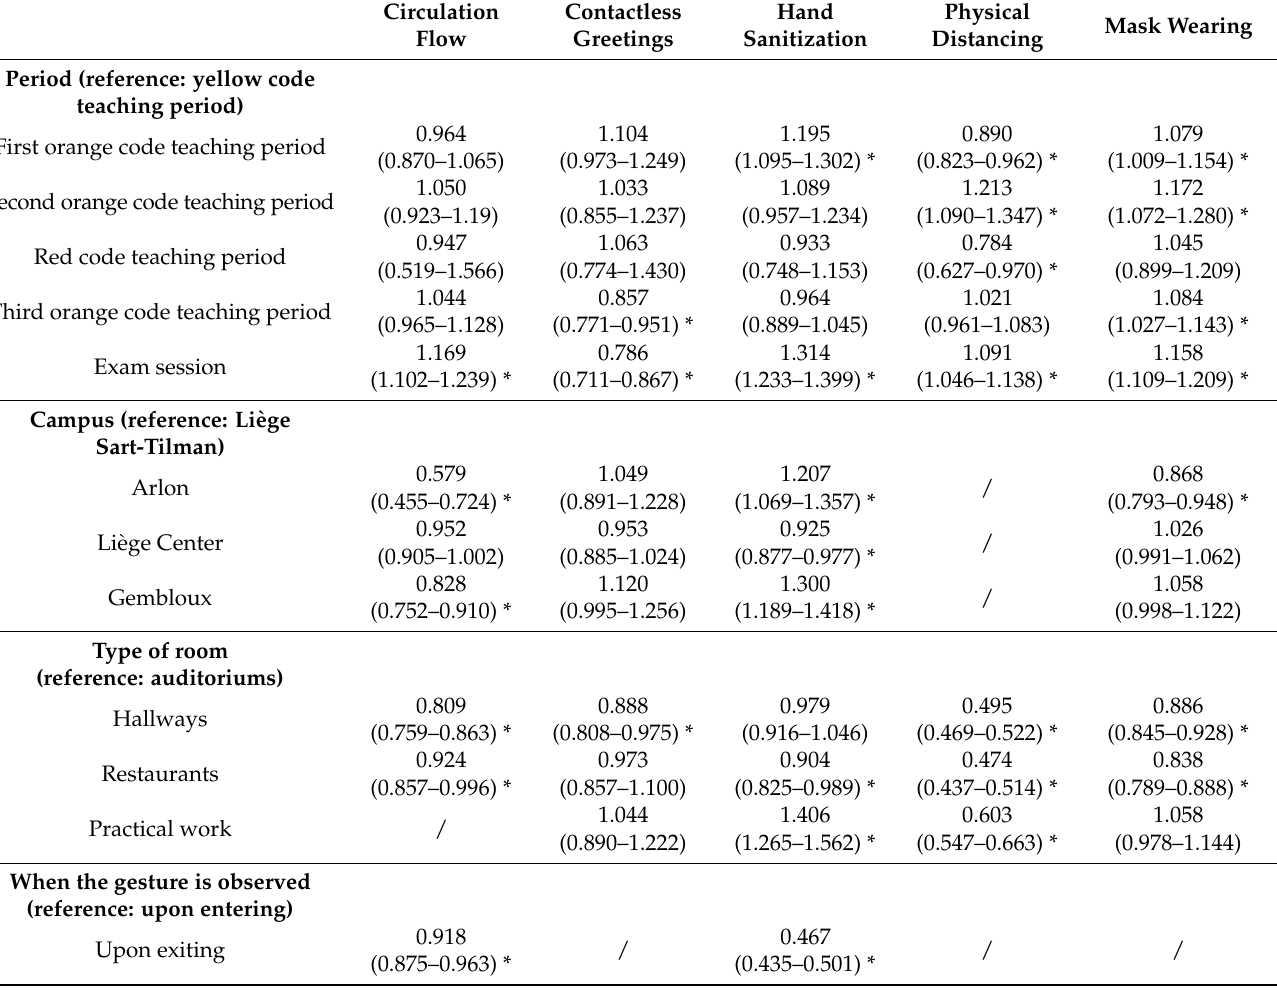
Table 3. Binary binomial negative regression prevalence ratios of the compliance with barrier gestures during both surveys (2020 and 2021) (95%